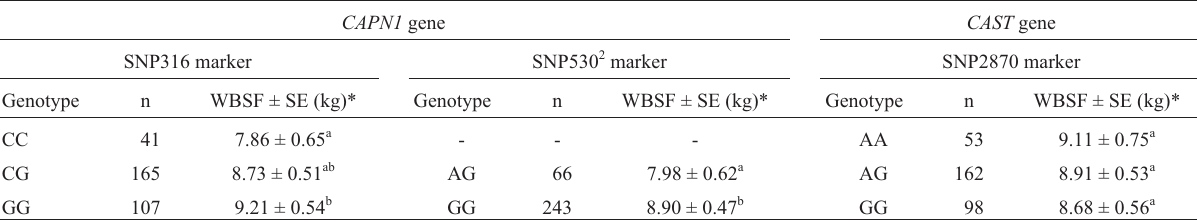
Table 3 - Mean Warner-Bratzler Shear Force (WBSF) values and standard error (SE) of the mean for genotypic classes based on individual poly- morphisms on the CAPN1 and CAST genes. Genotype AA at the SNP530 locus was not included in the analysis due to the low number of animals in this